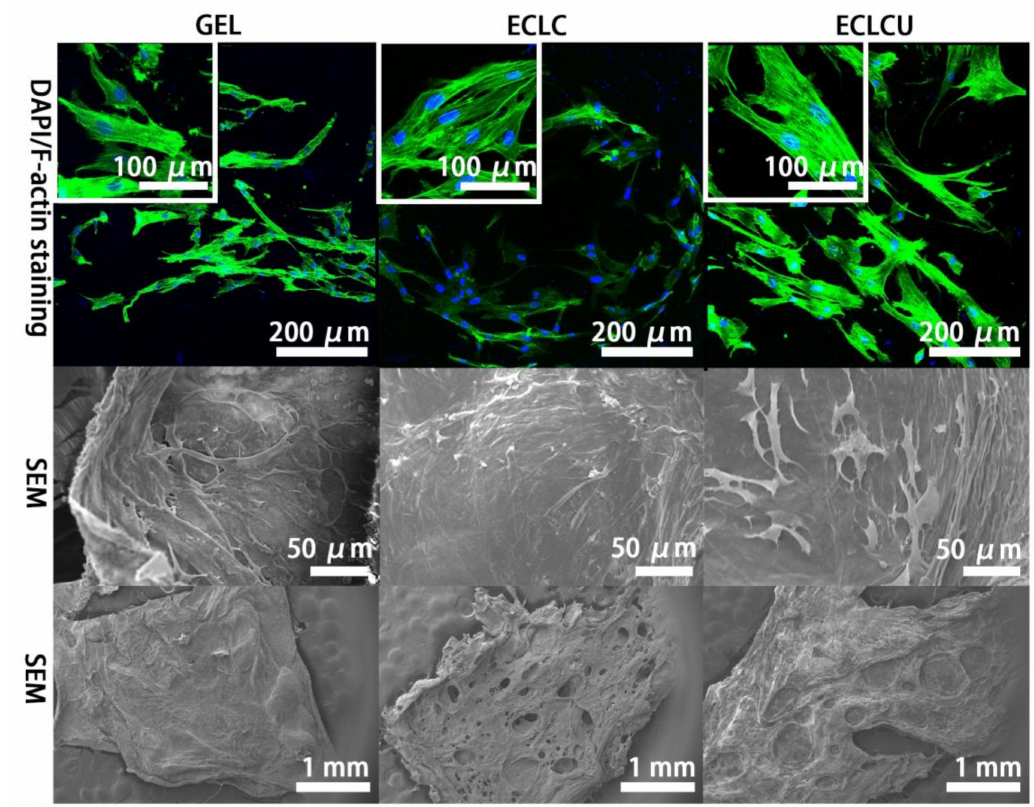
Figure 8. Representative F-actin filament staining with Alex-488 Phalloidin (staining F-actin in green)/DAPI (staining cell nucleus in blue) staining; SEM images of HDFs cultured on fabricated scaffold for 7 days; overall morphology of cell-material complexes after 7 days’ cell